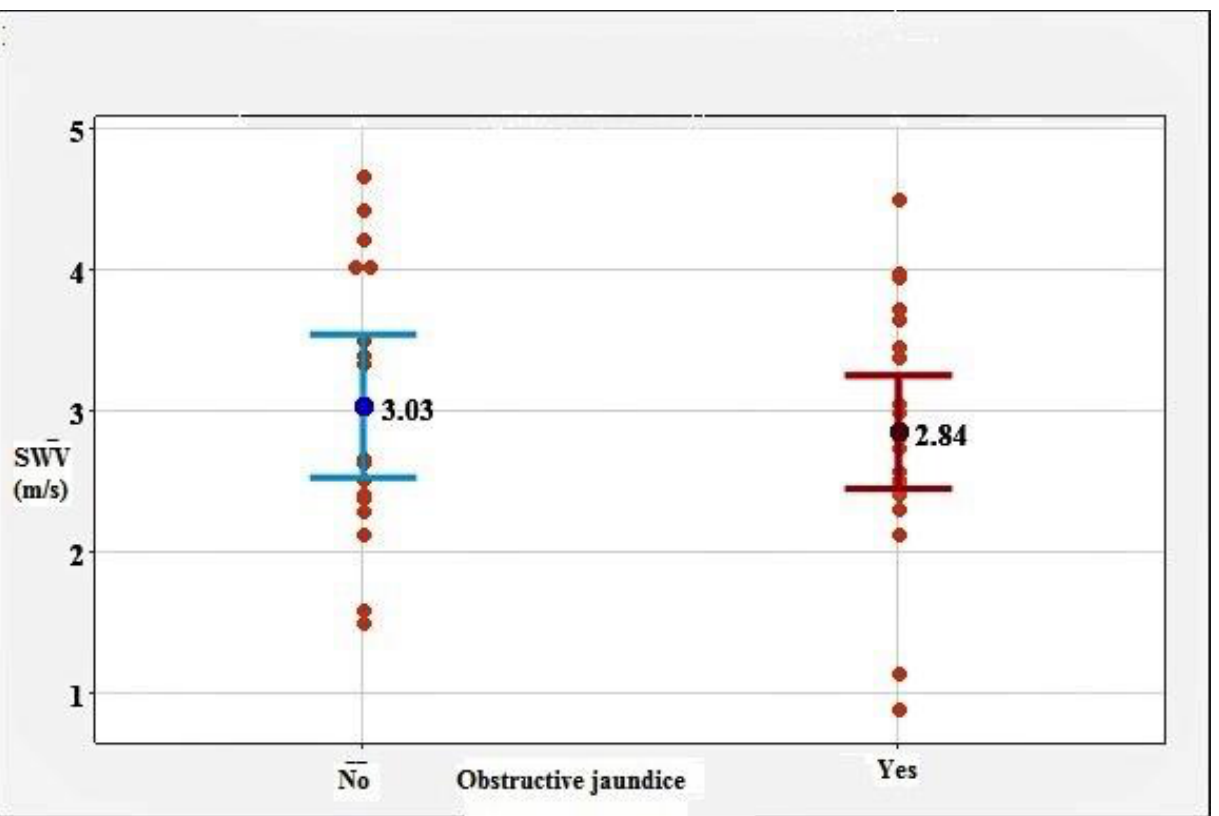
Figure 3. SWV values in correlation with obstructive jaundice.